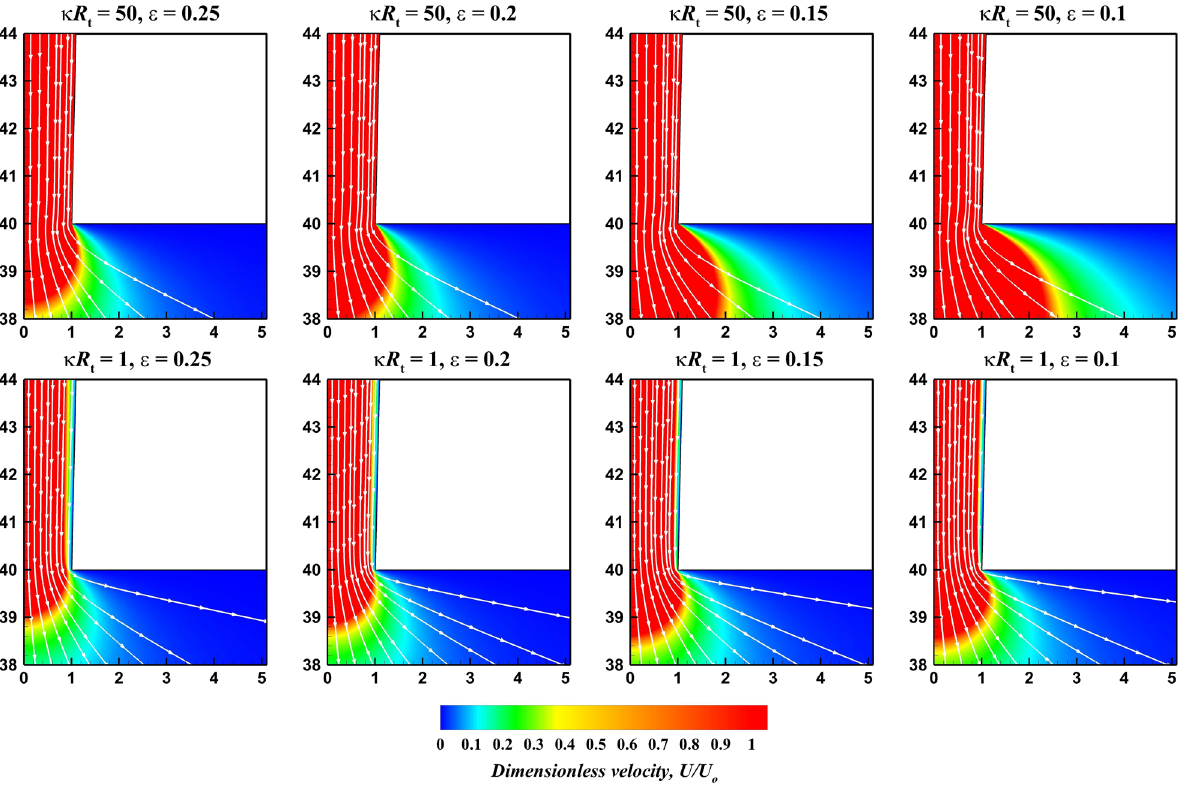
Figure 5. Representative streamlines and velocity contours at De = 100 , V = 40 , σ = − 50 and extreme values of κ R t and ε